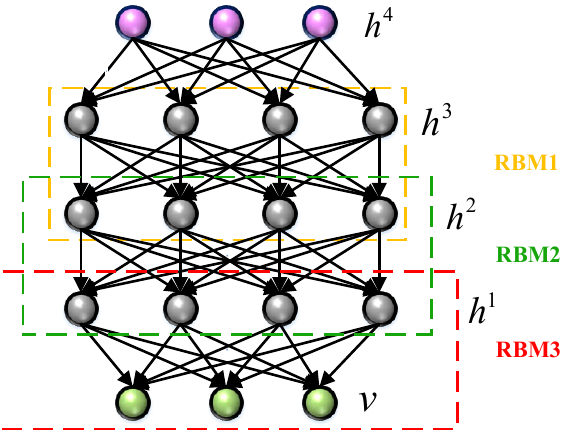
Figure 5. DBN structure.